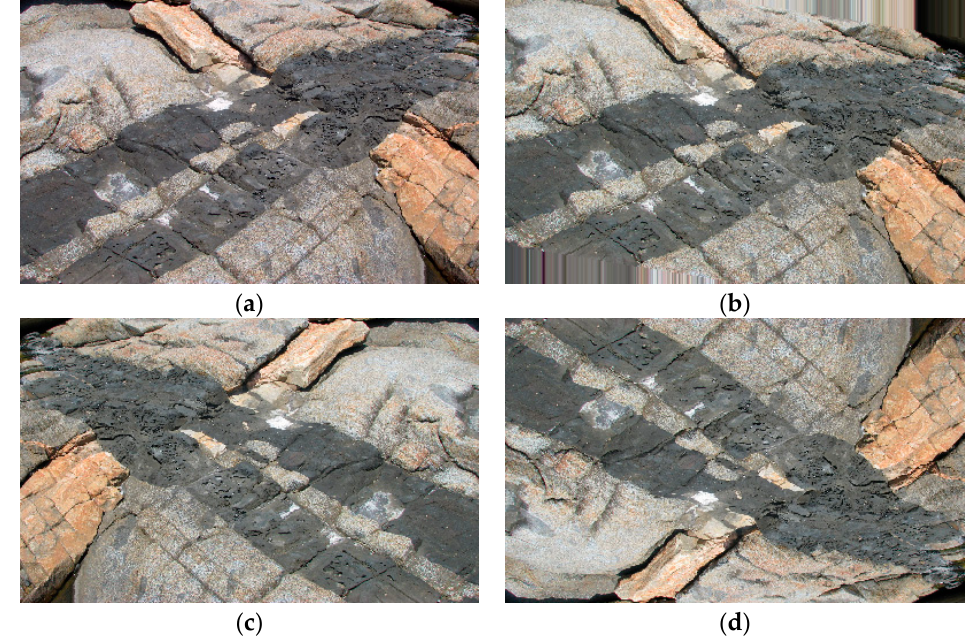
Figure 3. Data augmentation: ( a ) Channel shift; ( b ) Shear; ( c ) Flip from left to right; ( d ) Flip from top to bottom.